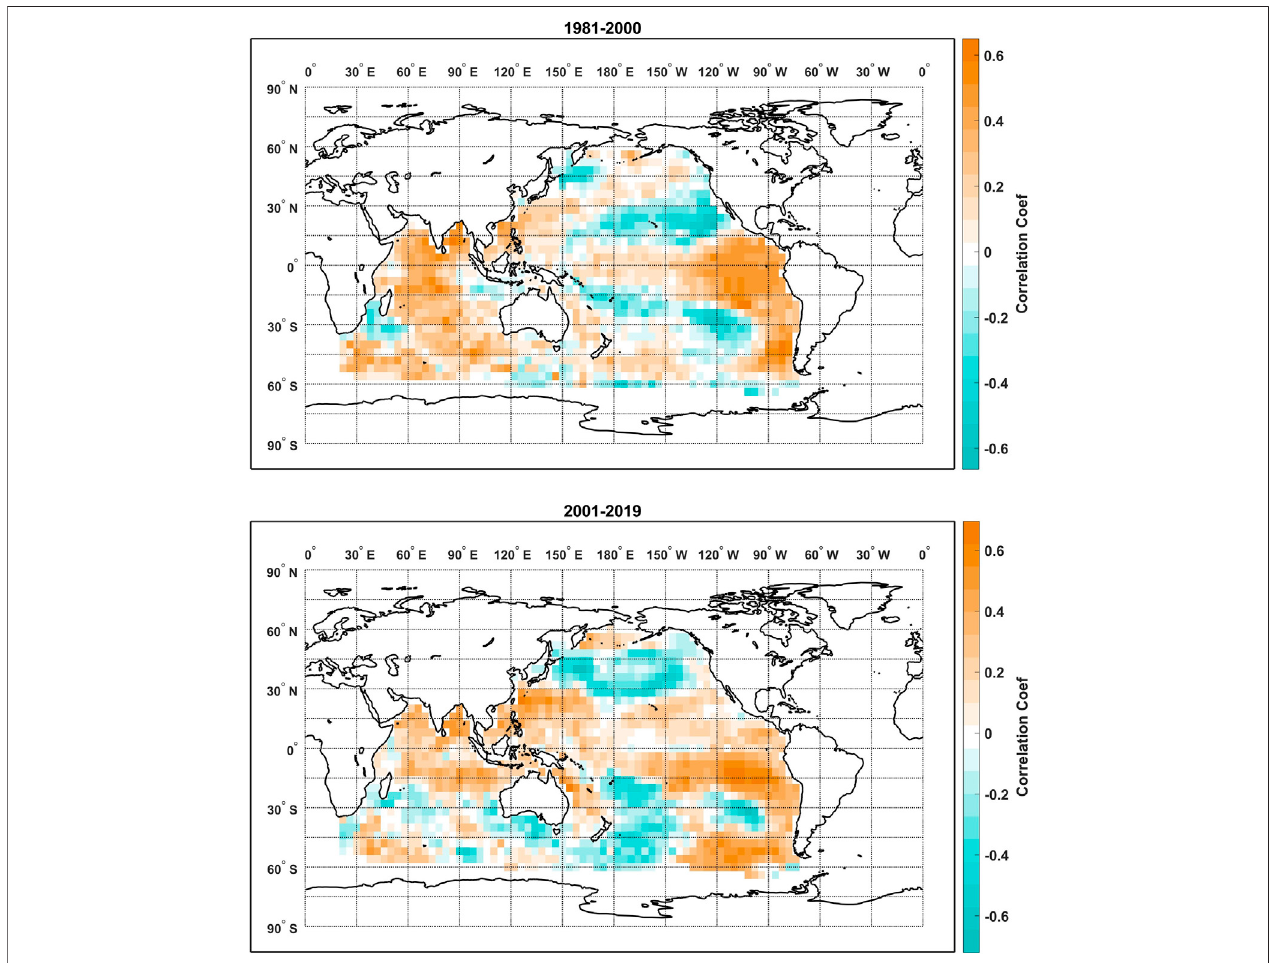
FIGURE 8 | Correlation maps between the TRHR precipitation and the SSTs over the training period of 1981 – 2000 (top) and the testing period of 2001 – 2019 (bottom) at the lead time of 22 months.